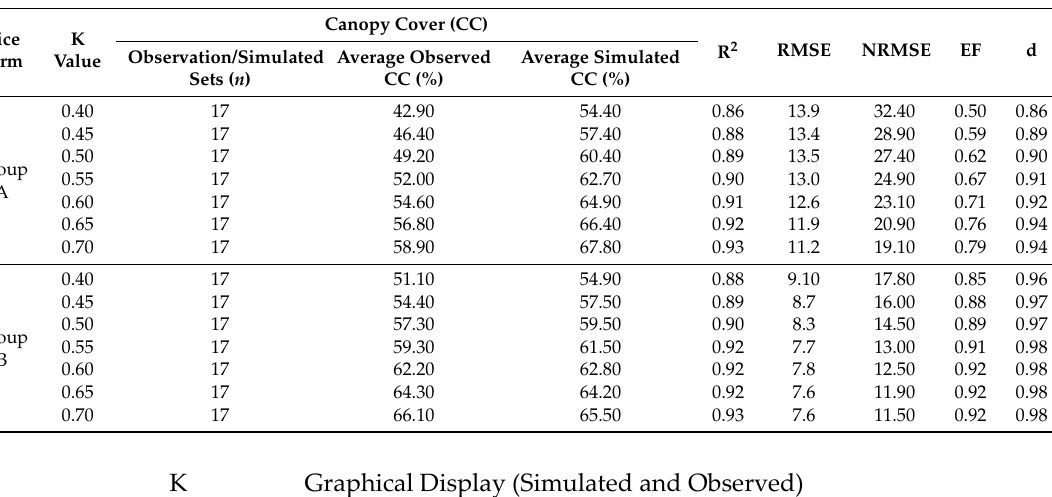
Table 6. Statistical indicators used for evaluating the CC simulation performance of the model using different K values for Groups A and B.